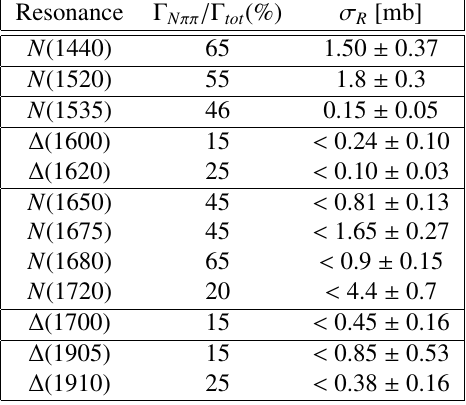
Table 1. Cross sections in units of mb for excitation of a positively charged resonance extracted from the one pion analysis [10].